Question: Write a descriptive caption for this figure.
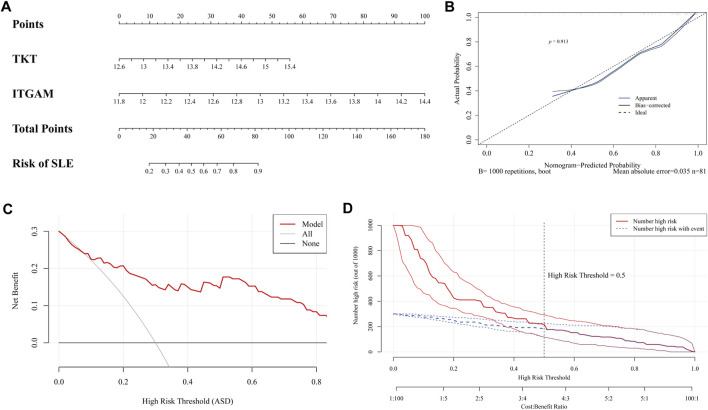
Answer: Development and evaluation of a nomogram for predicting the risk of SLE. (A) The nomogram was constructed to quantify each biomarker’s contribution and predict the risk of SLE in the training cohort. (B) The calibration curve, evaluated by the Hosmer-Lemeshow (HL) test (p = 0.913), demonstrated excellent agreement between predicted and observed outcomes, indicating a good model fit. (C) Decision curve analysis (DCA) revealed the superior net benefit of the nomogram across a range of threshold probabilities, supporting its clinical utility. (D) The clinical impact curve (CIC) further highlighted the nomogram’s satisfactory clinical applicability and predictive performance.